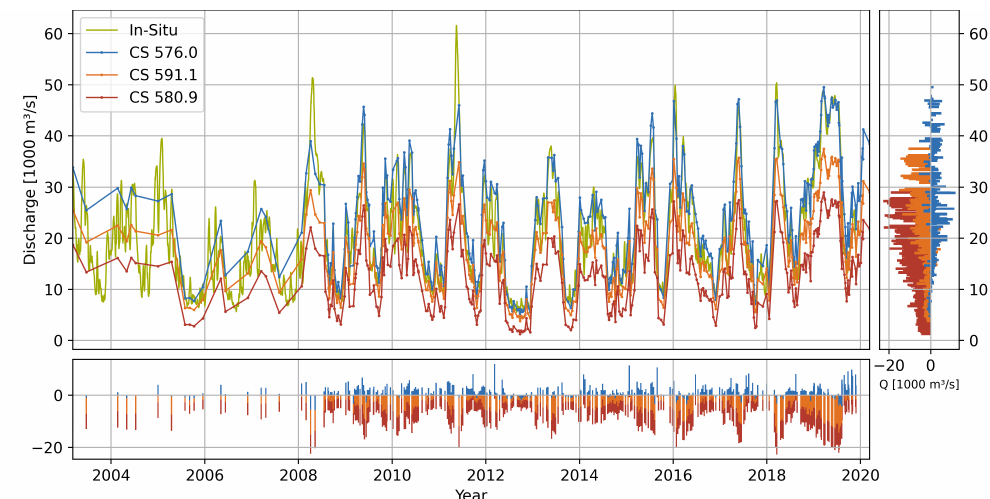
Figure 11. Discharge time series with residuals per time (horizontal) and discharge (vertical) of selected cross-sections at